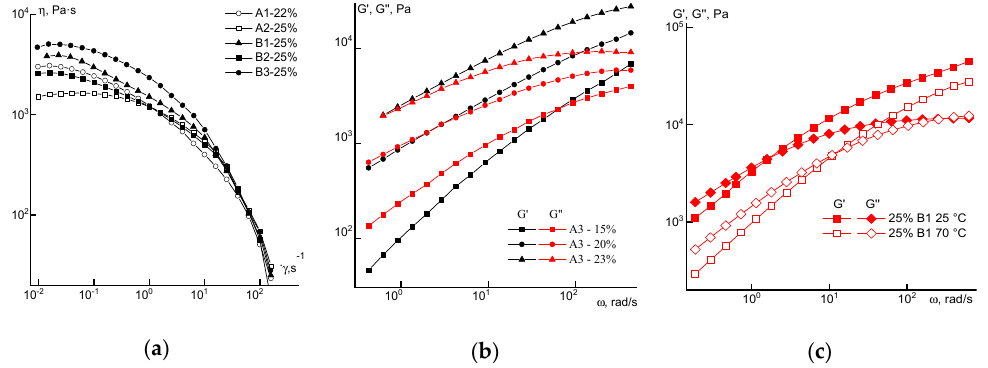
Figure 12. Flow curves ( a ) and frequency dependences ( b , c ) of dynamic moduli for solutions of the selected